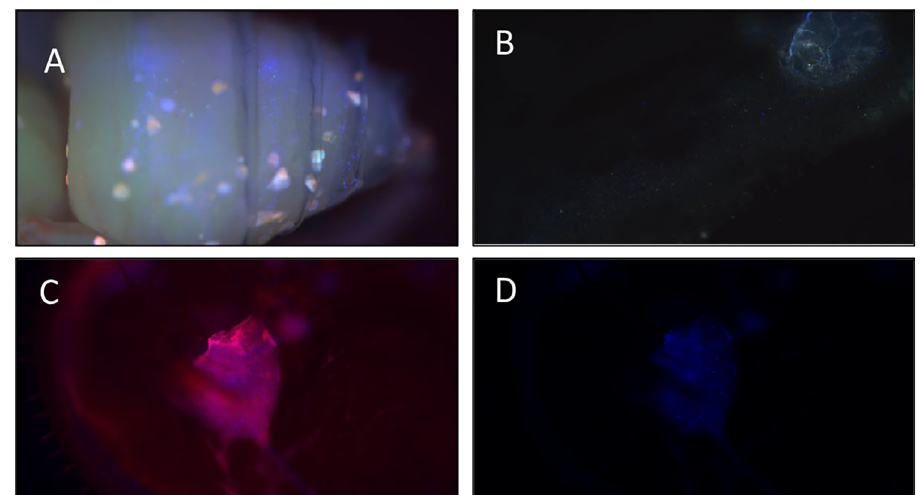
Fig 2. A. DAPI microspheres 1.0um, blue [365/415], Invitrogen, Thermo Fisher Scientific visualized under fluorescent microscopy through the cuticle of a worker pupae. B. DAPI FluoSpheres present in a Varroa which fed upon an injected adult bee. C-D The dorsal surface was partially removed to visualize the microspheres within the Varroa